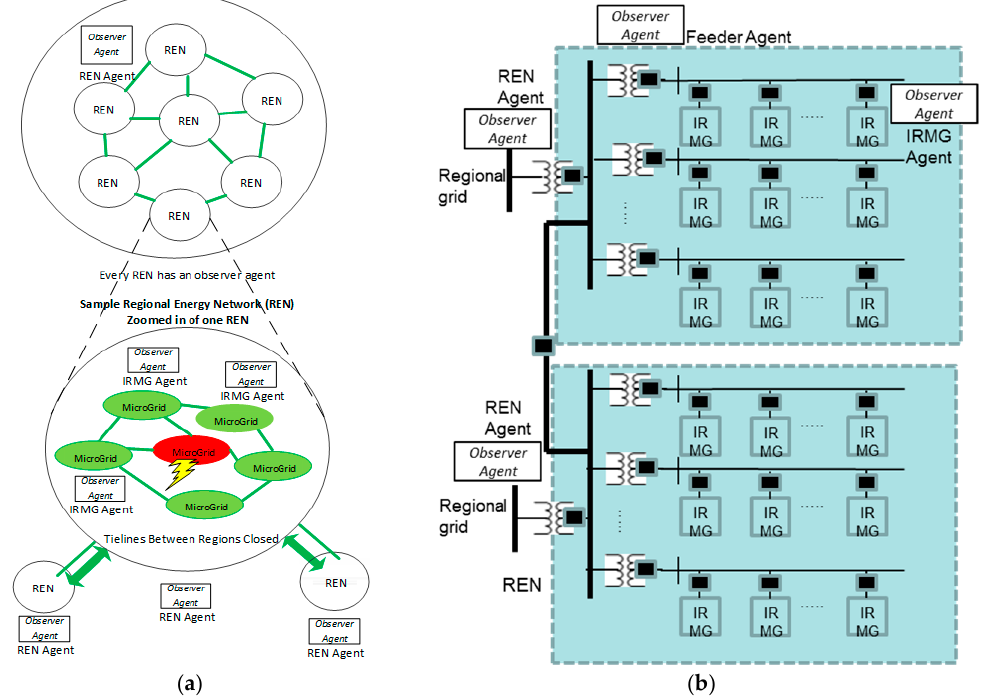
Figure 19. ( a ) A large power system divided into interconnected RENs and a sample REN consisting of networked IRMGs; and ( b ) a collection of IRMGs and two RENs in a radial distribution system.